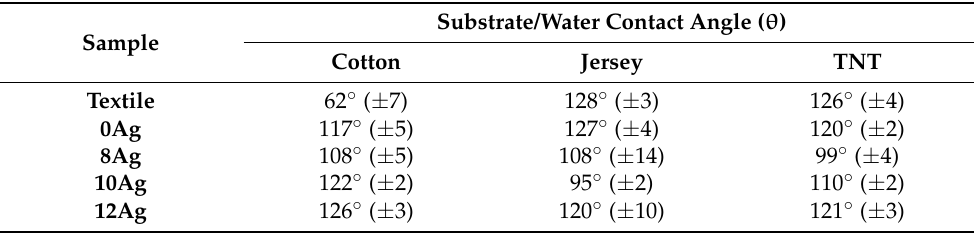
Table 2. Contact Angles ( θ ) results for the coated and uncoated substrates using water as the refer- ence liquid.